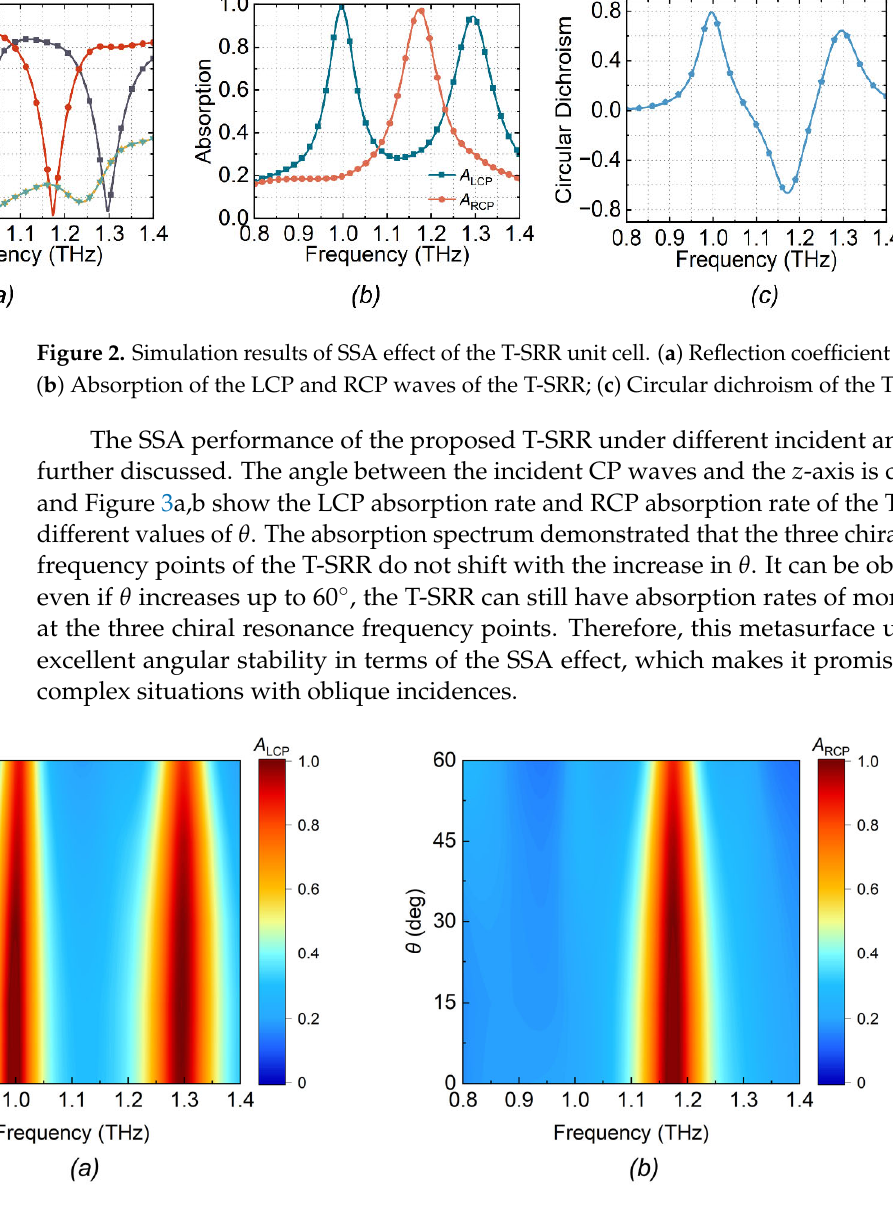
Figure 3. Simulated absorption spectrum of the T ‐ SRR unit cell under different oblique incident angles. ( a ) Absorption of LCP waves; ( b ) Absorption of RCP waves. angles. ( a ) Absorption of LCP waves; ( b ) Absorption of RCP